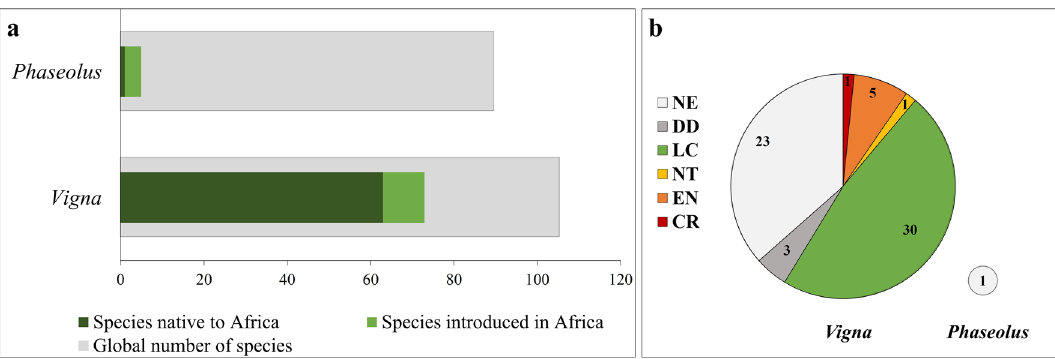
Figure 1. The genera Vigna and Phaseolus in Africa: ( a ) Number of species of Vigna and Phaseolus occurring globally (total number of accepted species), occurring in Africa and native to Africa; ( b ) Conservation status of Vigna and Phaseolus species native to Africa continent (IUCN conservation status: CR, Critically Endangered; EN, Endangered; VU, Vulnerable; NT, Near threatened; LC, Least concern; DD, Data deficient; NE, Not